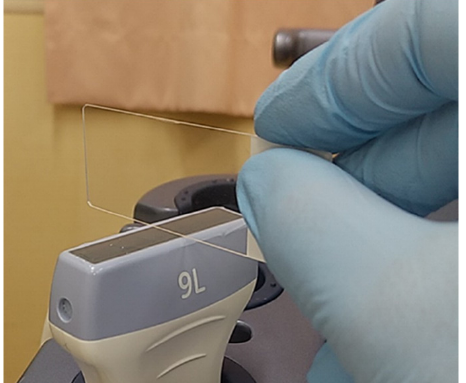
Figure 11. Simple educational materials that help provide an understanding of the influence of machine settings on the configuration of vertical artifacts. A glass microscope slide is placed perpen- dicularly on the footprint of a linear transducer with a thin layer of ultrasound gel.